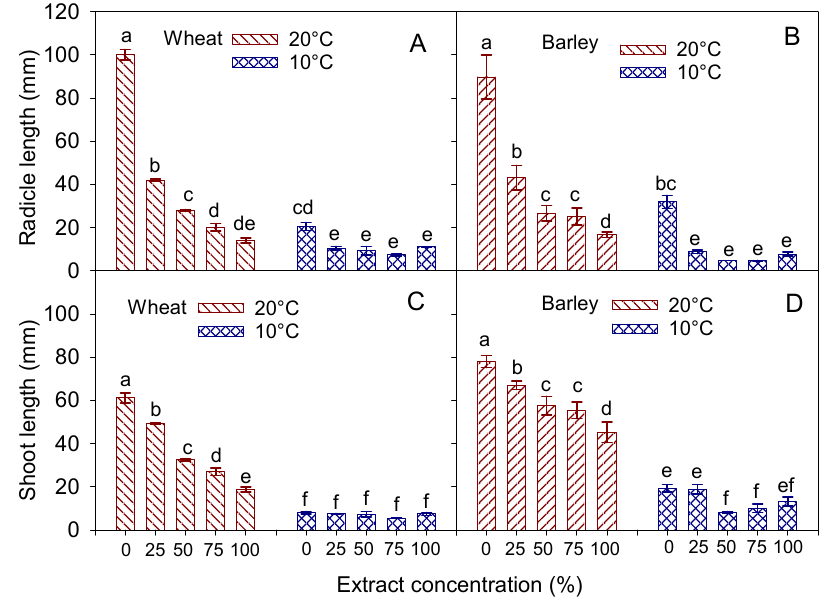
Figure 4. Interaction effect of ‘temperature × extract concentration’ on the length of radicle and shoot, in wheat cv. Mongibello ( A , C ) and barley cv. Alamo ( B , D ). Data are means ± se ( n = 4). Different letters in barley indicate significance at p < 0.05 according to Tukey’ test.